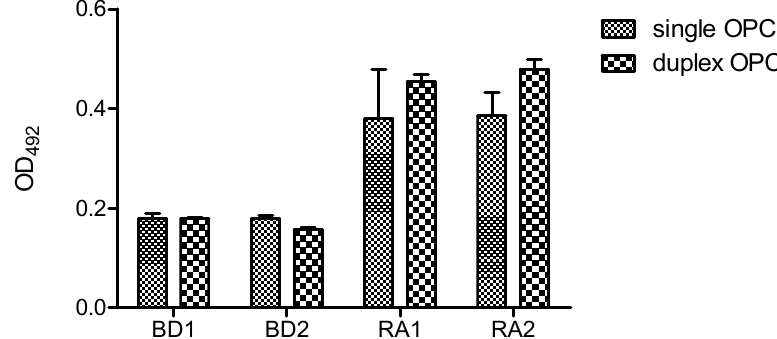
Figure 7. Reactivity of rheumatoid arthritis (RA) and blood donor (BD) sera with single and duplex OPC (OPC-8 with its complementary strand 5 ′ AAGAGAAAAGAATTTTT- NH 3 ′ ). A concentration of 25 pmol/well of each OPC was immobilized via amine groups 2 on DNA-Bind TM plates.